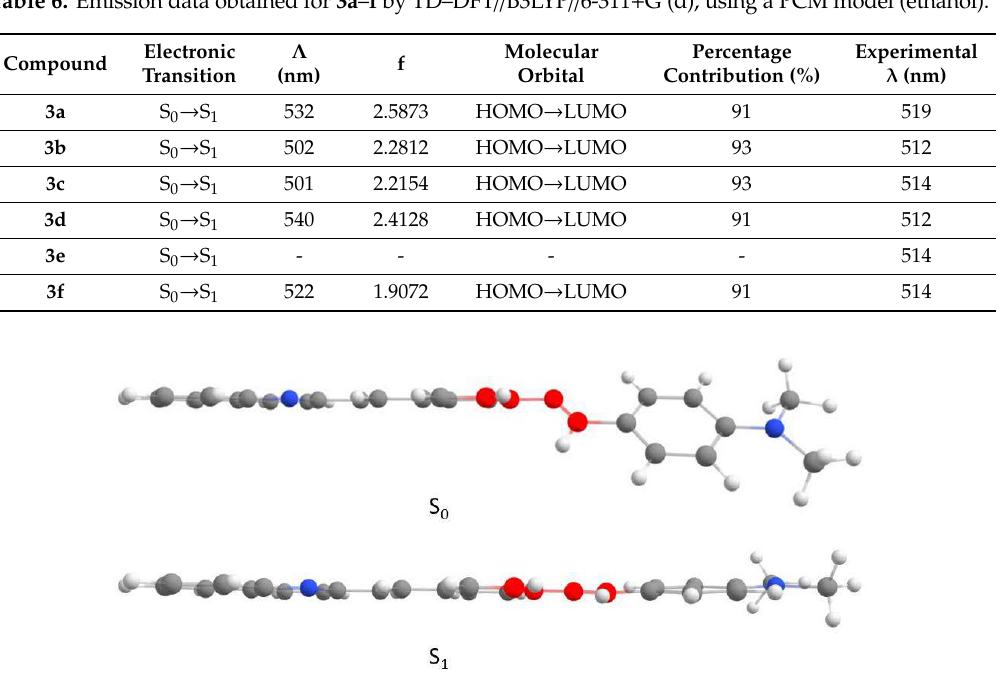
Figure 8. The geometry of compound 3a in the ground and excited states, which was obtained by TD–DFT // B3LYP // 6-311 + G (d). Table 7. Comparison of a compound’s geometry in the ground and excited states.